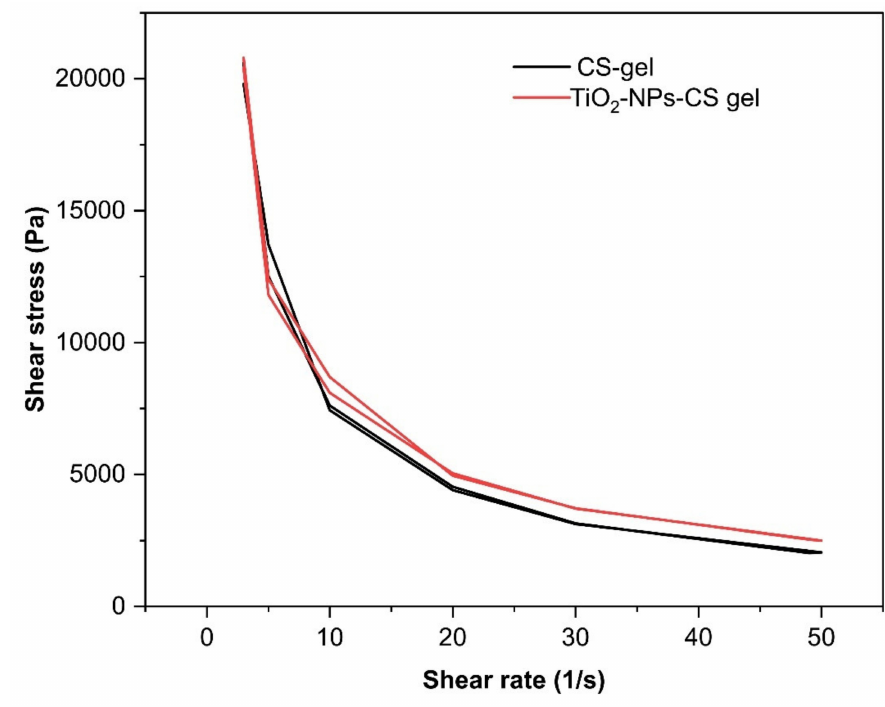
Figure 6. The rheological profile of CS gel and CS gel containing TiO 2 NPs exhibited pseudoplastic